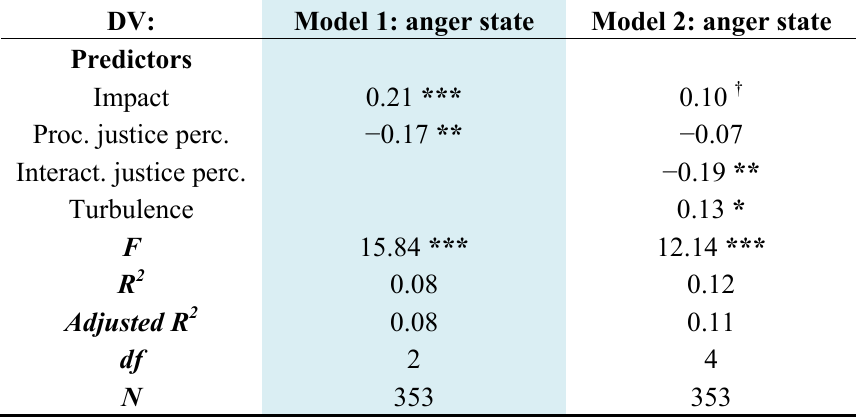
Table 2. Stepwise regression from context factors to anger state a